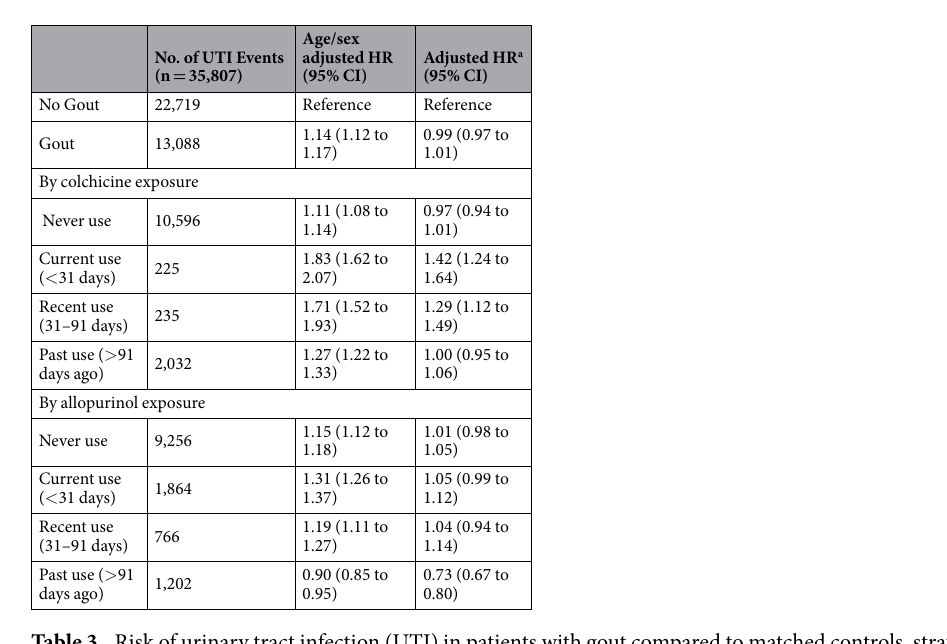
Table 3 shows that gout was associated with a 14% increased risk of UTI, after adjustment for age and sex (HR 1.14, 95% CI 1.12 to 1.17). After full statistical adjustment this increased risk disappeared (adj. HR 0.99, 95% CI 0.97 to 1.01). The following confounders were responsible for this shift: sex, a history of chronic kidney disease,